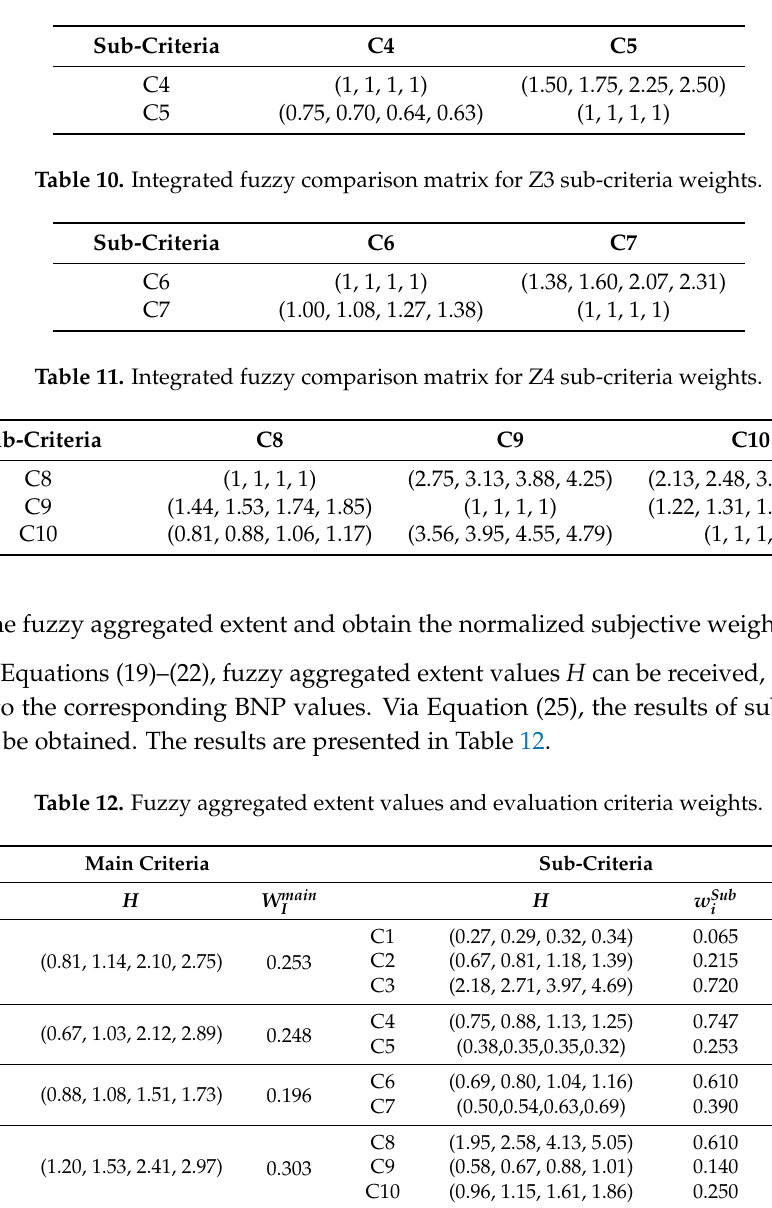
Table 9. Integrated fuzzy comparison matrix for Z2 sub-criteria weights.